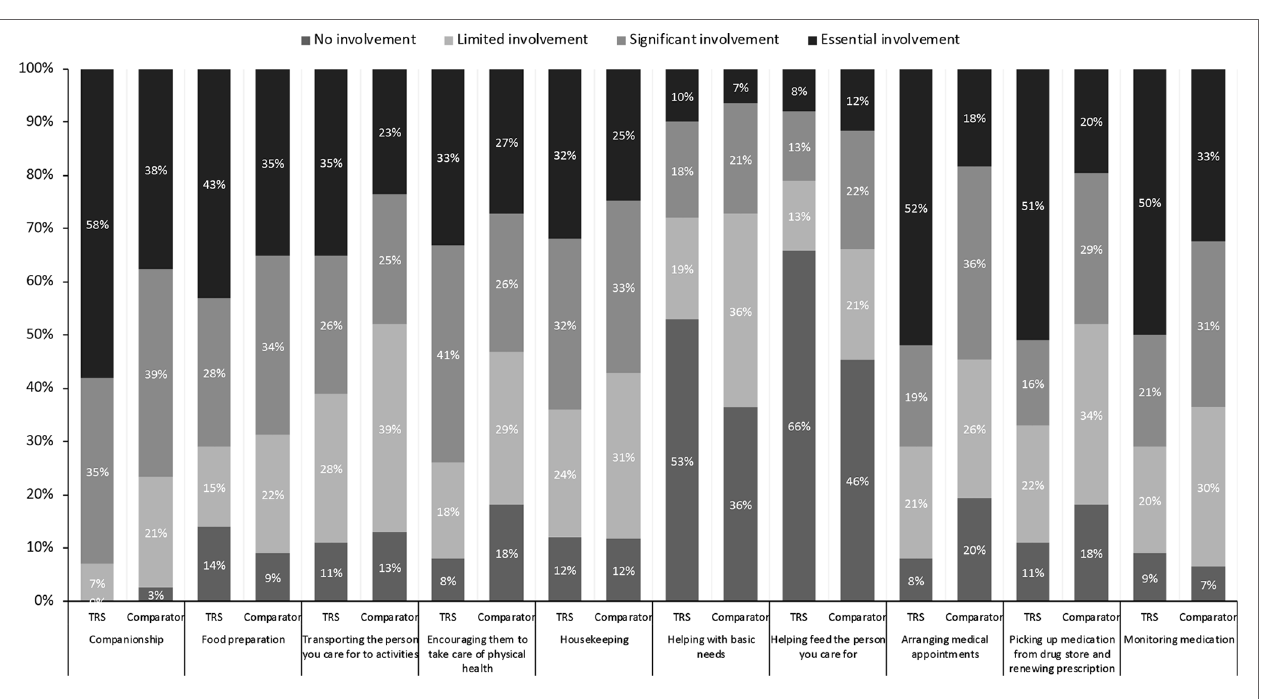
FIGURE 6 | Fears of the care recipient causing harm to self or